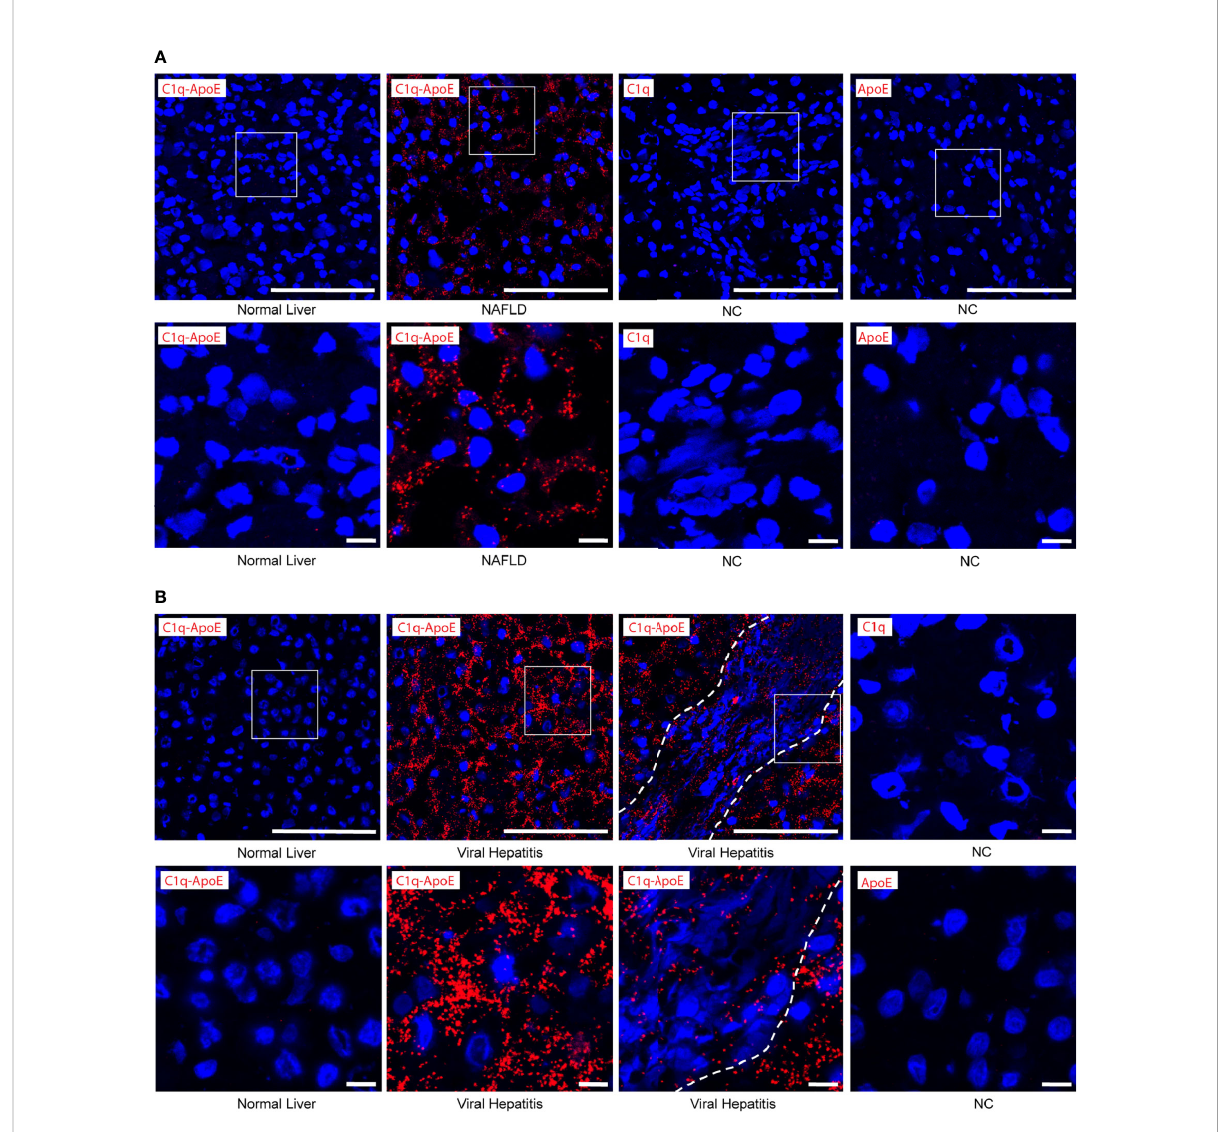
FIGURE 7 C1q-ApoE complex formation in human livers. (A, B) Human liver sections were stained with C1q and ApoE by PLA. Anti-C1q alone or Anti-ApoE alone were used as negative controls. Dotted lines demarcate immune cell in fi ltrates from adjacent liver parenchyma. White squares represent high magni fi cation images shown separately. Scale bar 100 m m in low magni fi cation images and 10 m m in images of high magni fi cation. Representative images of human samples (Supplementary Table 1) are shown. (A) Normal liver sample Nr. 2 (Supplementary Table 1); NAFLD sample Nr.